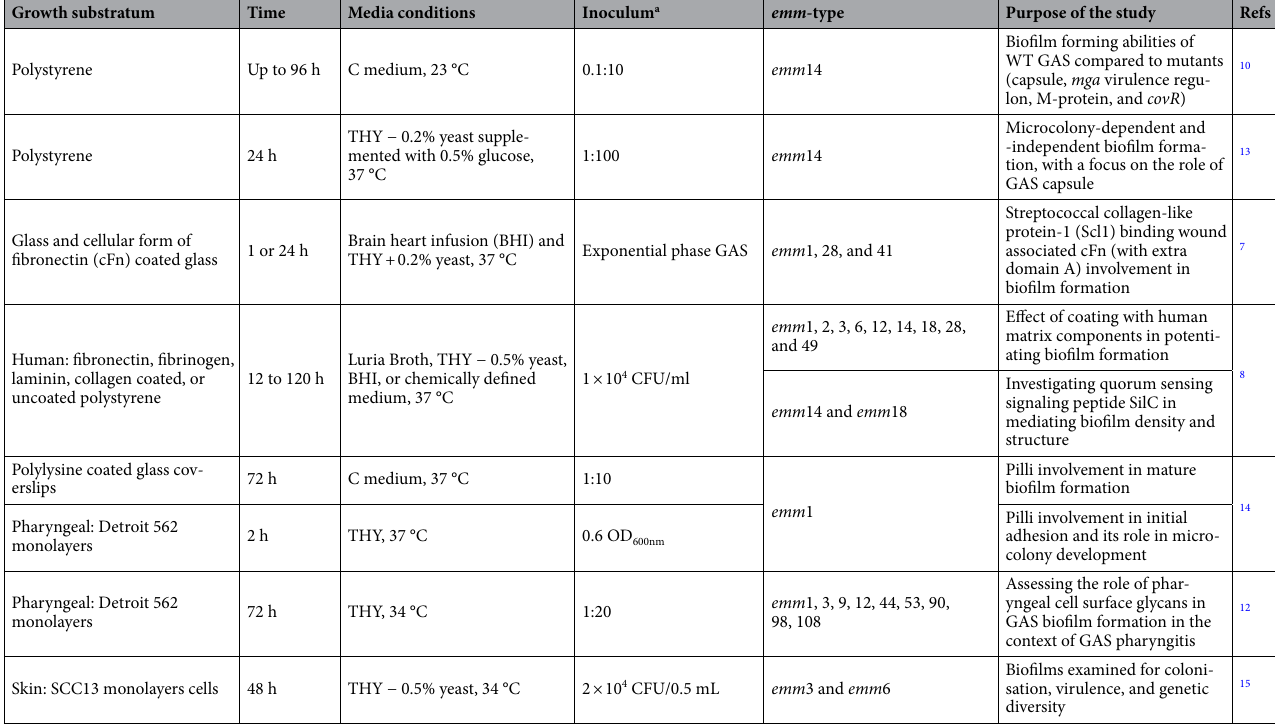
Table 1. Examples of in vitro plate-based models used for the study of GAS biofilm formation. a Inoculums listed as ratios (bacteria: bacterial media), growth phase, or optical density.